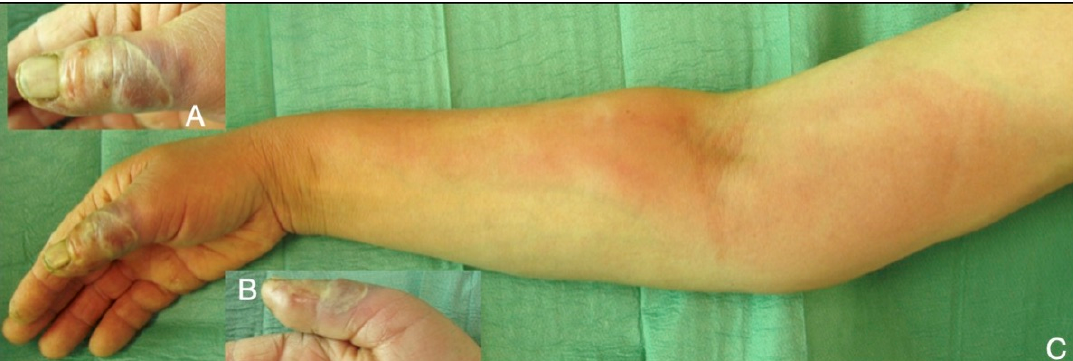
Figure 5. Necrotic cellulitis of the thumb ( A , B ), rapidly developed lymphangitis and spread till the lymph nodes of the distal humerus ( C ).